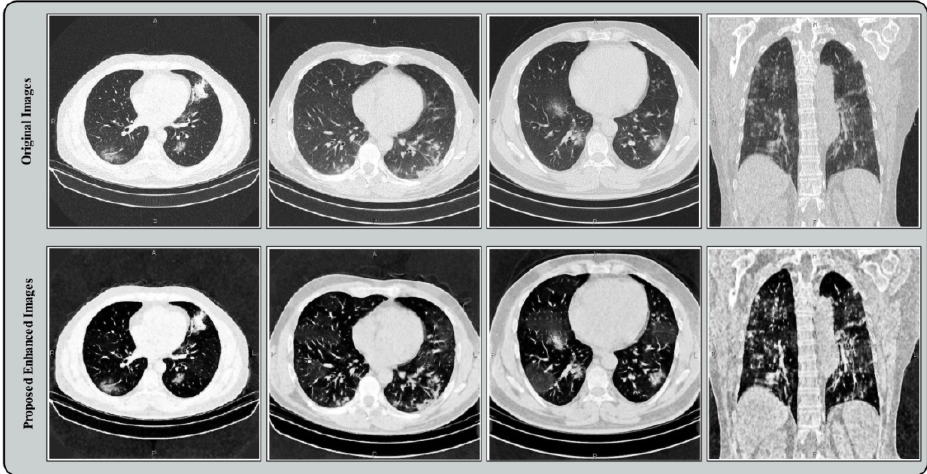
Figure 3. Proposed contrast enhancement effects on the original chest CT images.